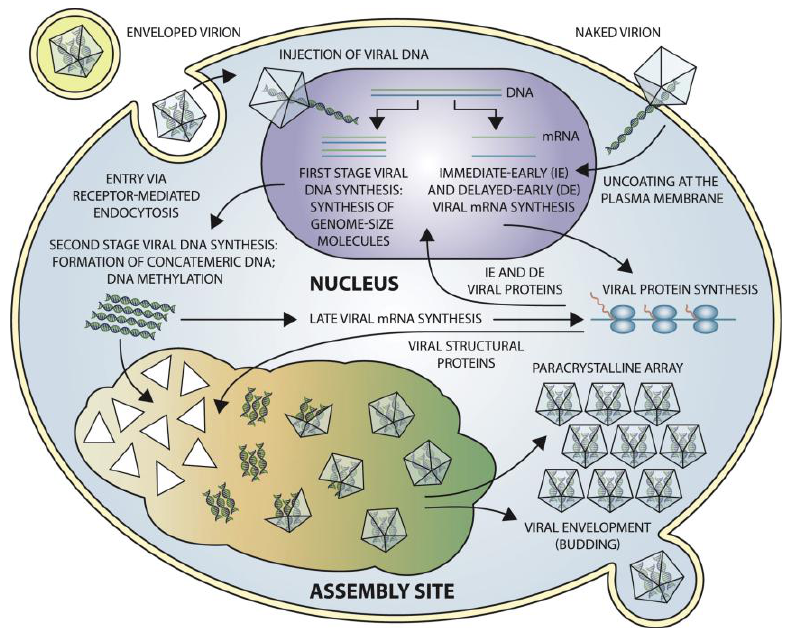
Figure 6. Schematic representation of iridoviral replication. This figure was obtained from the 10th report of ICTV with permission [1,2].